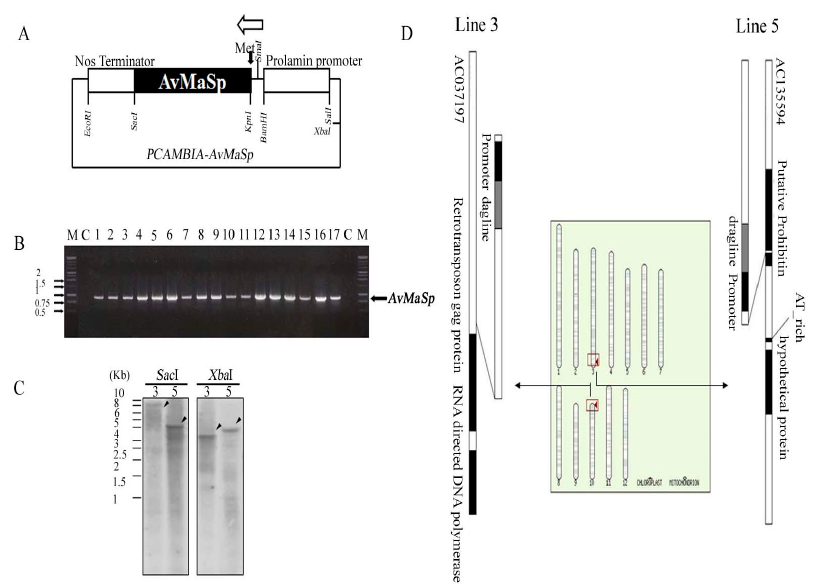
Figure 1. Characterization of the transgenic rice lines. ( A ) Constructed pCAMBIA-AvMaSp vector. To generate the transgenic rice plants, AvMaSp was introduced under the control of the Prolamin promoter. ( B ) Screening of the transgenic lines expressing AvMaSp using PCR. The AvMaSp gene was amplified from the genomic DNA of the transgenic rice lines using gene-specific primers, with Dong-Jin DNA used as the control C. ( C ) Identification of the single-copy AvMaSp insertion in the transgenic lines using a Southern blot analysis. ( D ) Determination of the location of the AvMaSp gene in the rice genome using a flanking DNA sequence analysis. Plants 2020 , 9 , x